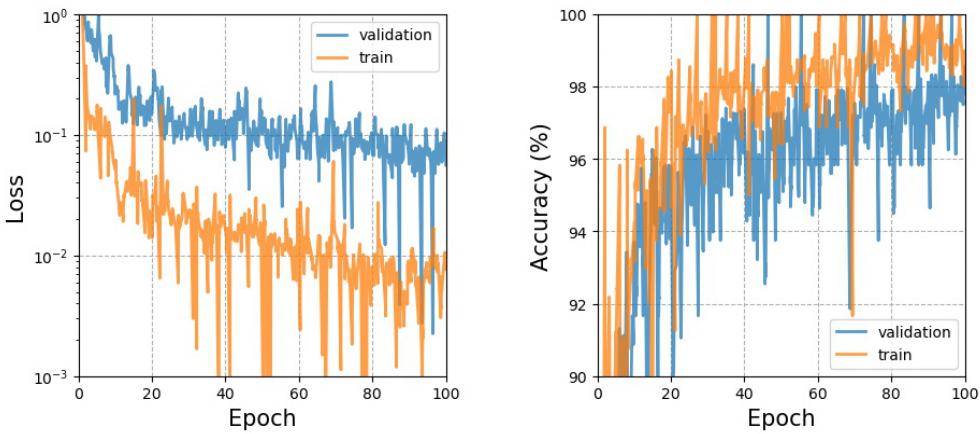
Figure 7. MWD-v4 training history of binary cross-entropy loss and accuracy calculated on the training and validation